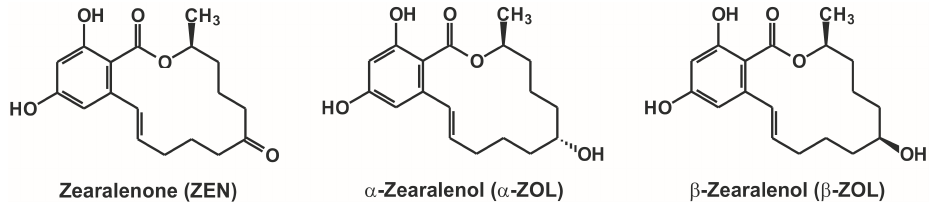
Figure 1. Chemical structures of zearalenone, α -zearalenol, and β -zearalenol.